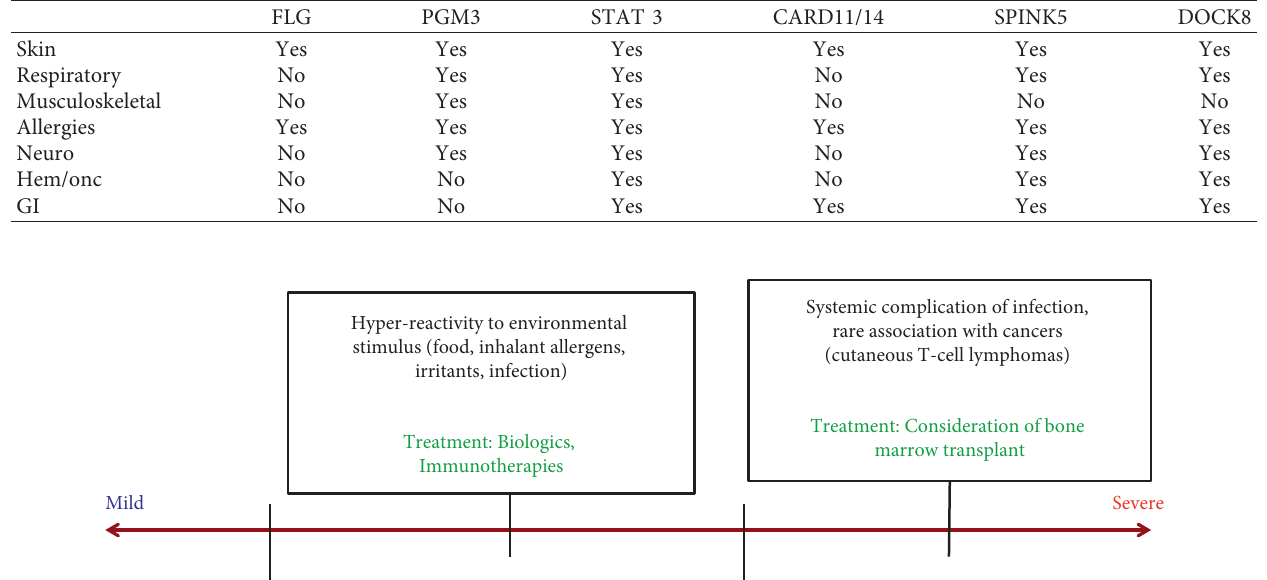
Table 1: Phenotypes of genes involved in patients with markedly elevated IgE